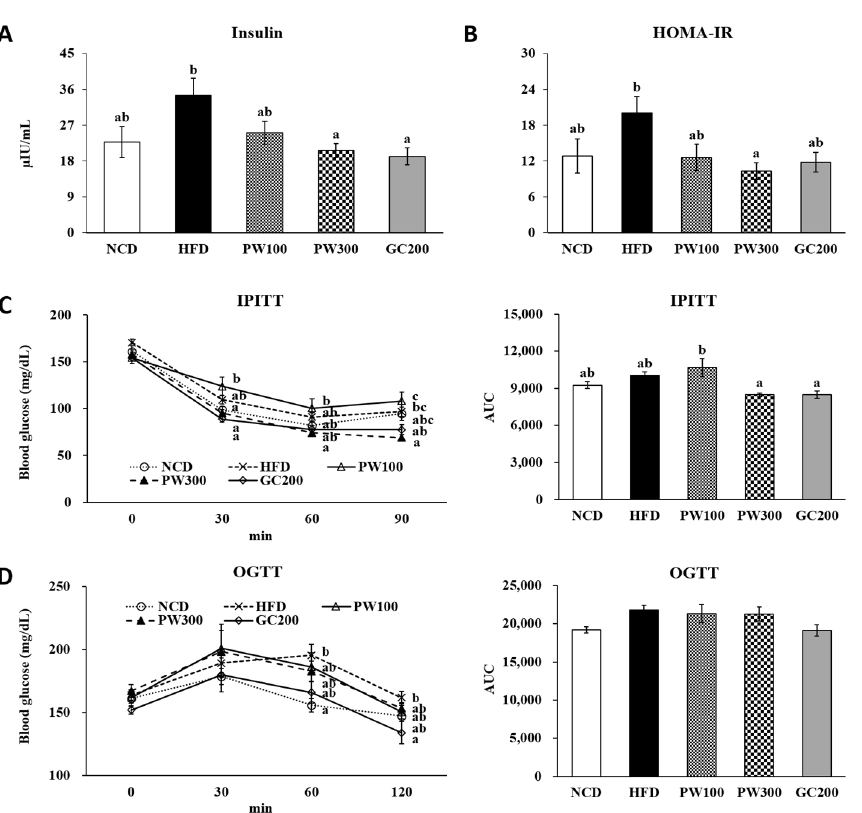
Figure 6. Effect of Polygonum multiflorum Thunb. hot water extract on serum insulin level ( A ), HOMA-IR index ( B ), IPITT ( C ), and OGTT ( D ) test in HFD-induced obese mice. Data are expressed as means ± SE. Values with different superscript letters are significantly different at p < 0.05 as determined by one-way ANOVA followed by Tukey’s HSD test. Homeostasis model assessment of insulin resistance (HOMA-IR) = fasting serum insulin (µIU/mL) × fasting serum glucose (mmol/L)/22.5. IPITT, intraperitoneal insulin tolerance test; OGTT, oral glucose tolerance test.